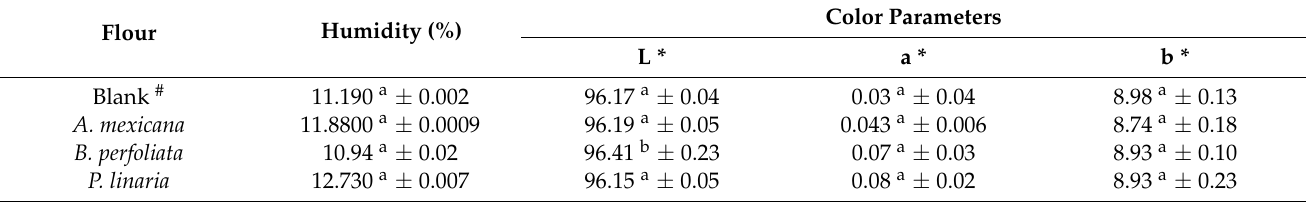
Table 5. Humidity and color parameters of flour from wheat treated with the essential oils.